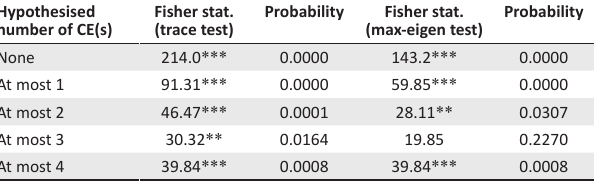
TABLE 5-A1: Johansen Fisher panel cointegration test with Quadratic deterministic